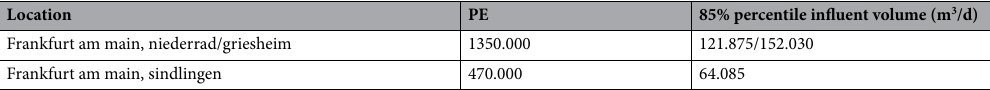
Table 1. Overview of the studied WWTPs in the city of Frankfurt am Main with the 85% percentile influent volume per day for the period 15.06–31.08.2020 and population equivalents (PE).